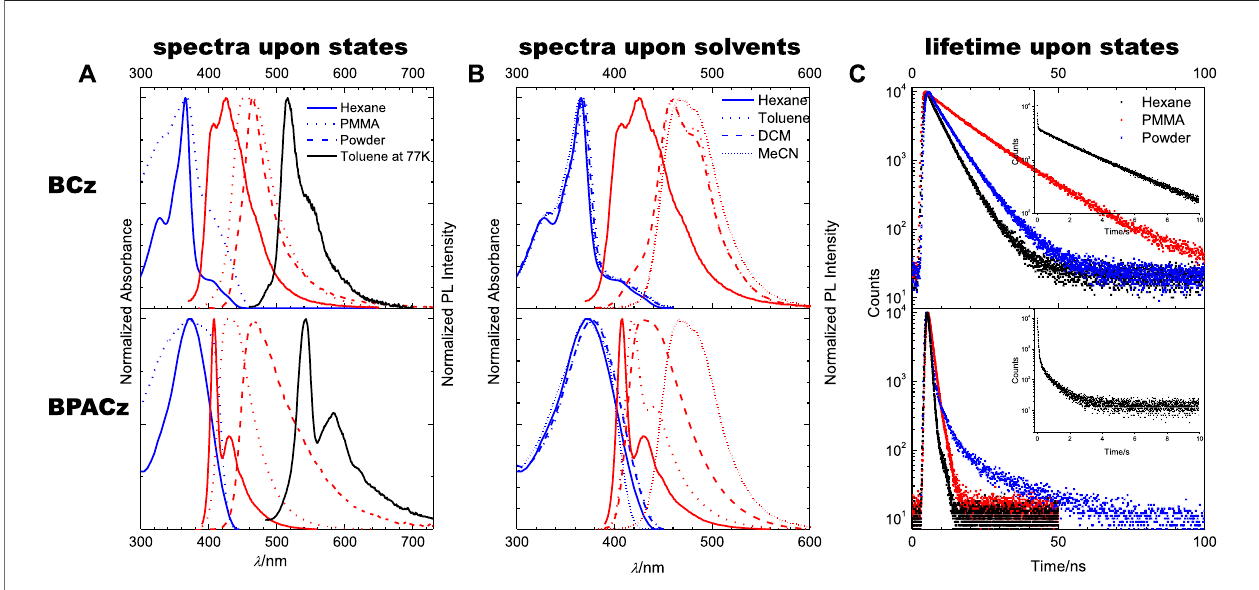
FIGURE1| Absorptionand PLpropertiesofBCz(top)theBPACz(bottom): (A) spectra(Absorptioninblue,PLinred)insolutionofhexane(solidlines),PMMA(dot lines)and powder(dashed lines)atroomtemperatureandPLspectraintolueneat77 K(in blacksolidline). (B) spectra(Absorption inblue, PLinred)indifferentsolvents (hexane,solidlines;toluene,dotlines;DCM,dashedlines;MeCN,shortdotlines)atroomtemperature. (C) PLlifetimesofBCzandBPACzinhexaneandPMMA,excited at 380 nm, the one of powder excited at 295 nm; the insets are PL lifetimes in toluene at 77